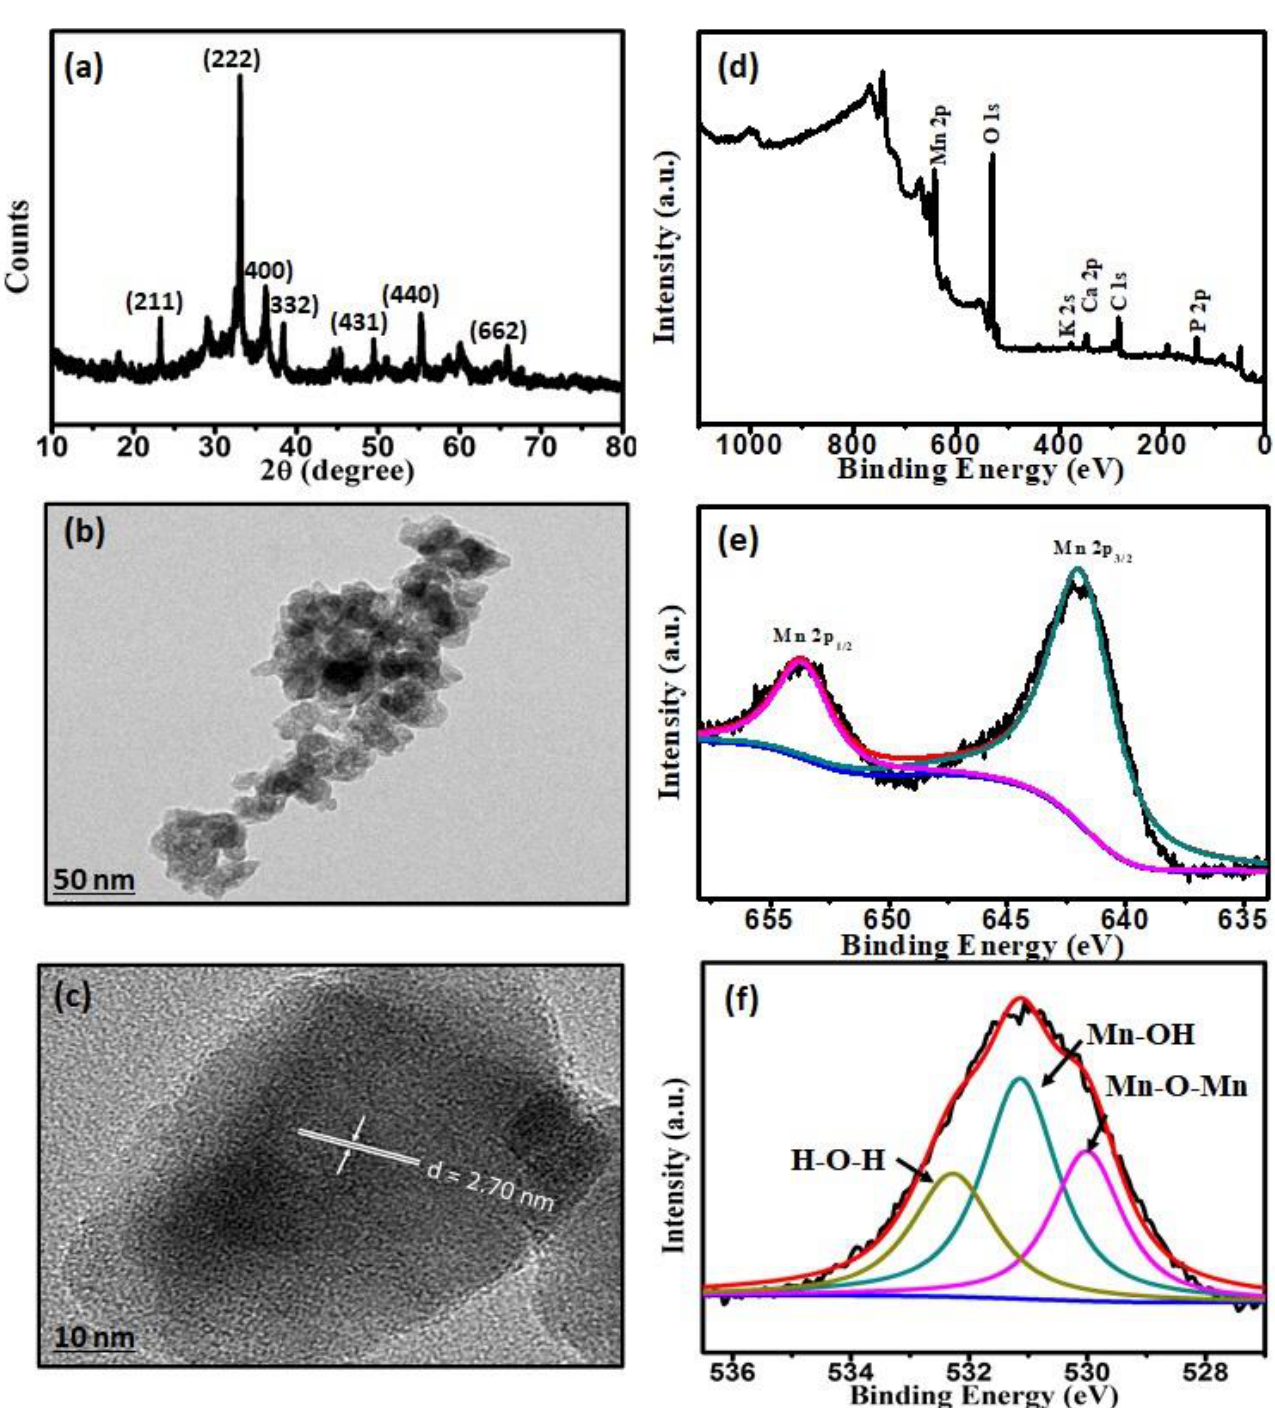
Figure 1. Characterization of MnO-NPs: ( a ) X-ray diffraction (XRD) pattern; ( b ) transmission electron microscopy (TEM) image; ( c ) high resolution (HR)-TEM image; ( d ) X-ray photoelectron spectroscopy (XPS) overview spectrum of MnO-NPs; ( e , f ) the narrow scan Mn 2p-electrons and O1s XPS spectrum of MnO-NPs,